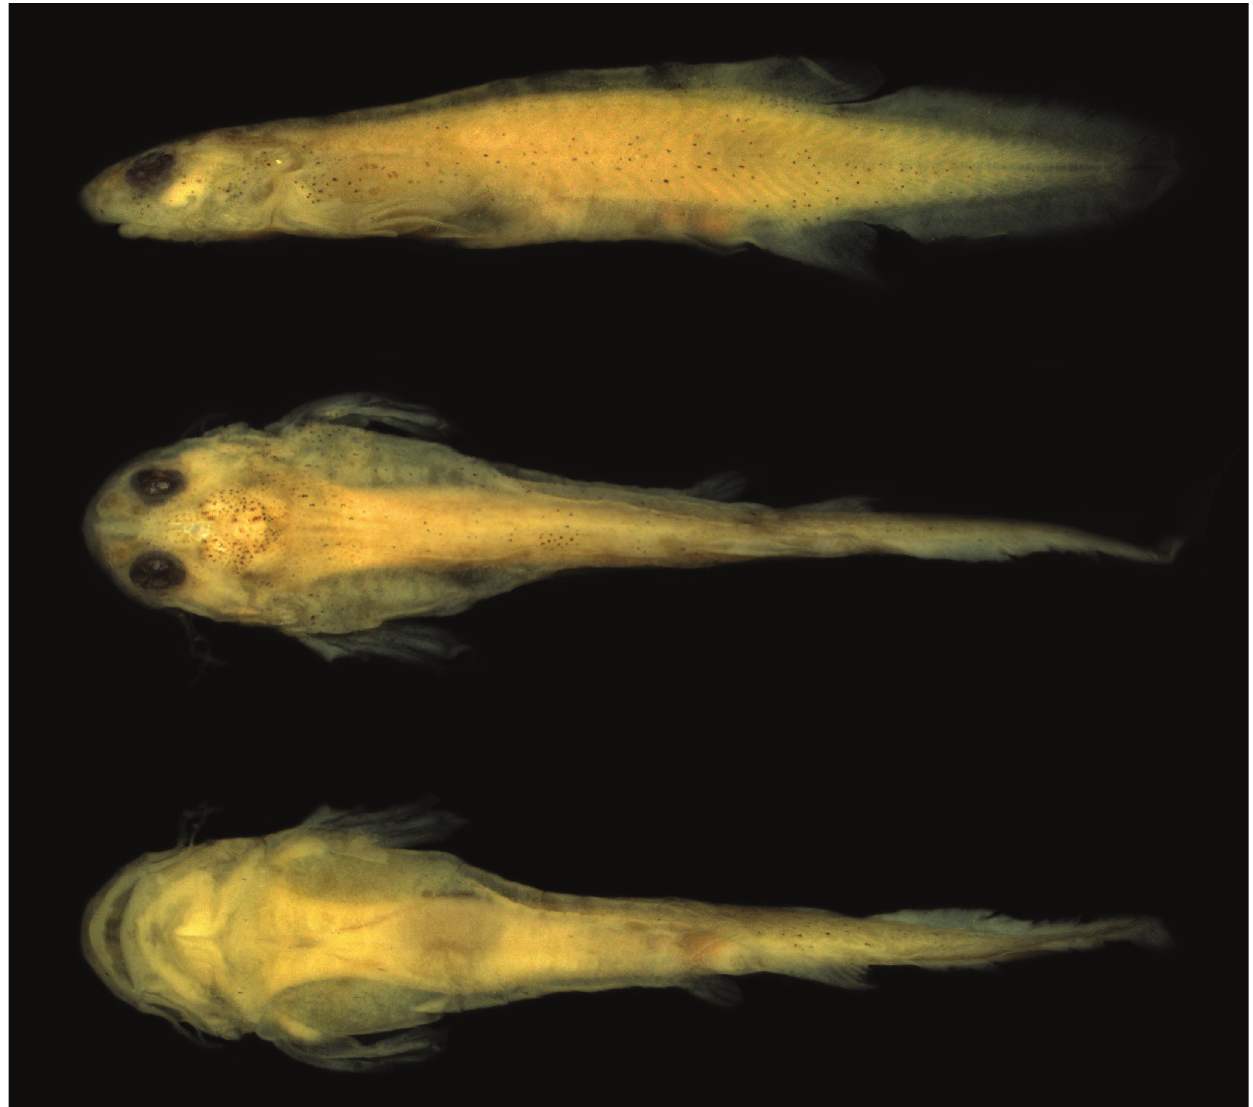
Fig. 4. Juvenile of Ochmacanthus alternus , FMNH 99611 (13.50 mm SL), Ecuador, Napo, tributary of Shusshufindi